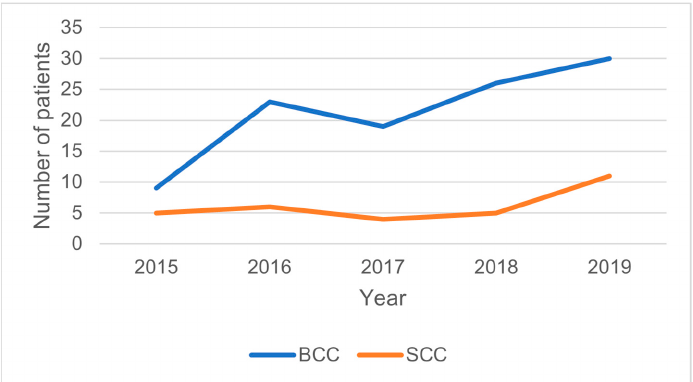
Figure 1. Year distribution of the skin cancer patients.